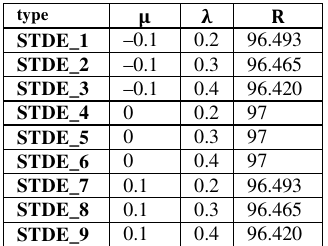
Table 2. Geometrical engine parameters for